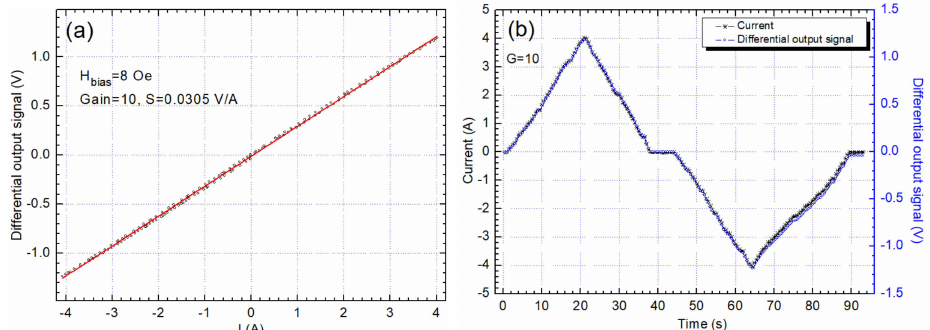
Figure 15. The response of the di ff erential system when the current varies between − 4 to 4 A following an arbitrary wave form: ( a ) di ff erential output characteristic, ( b ) the signals variation over time.